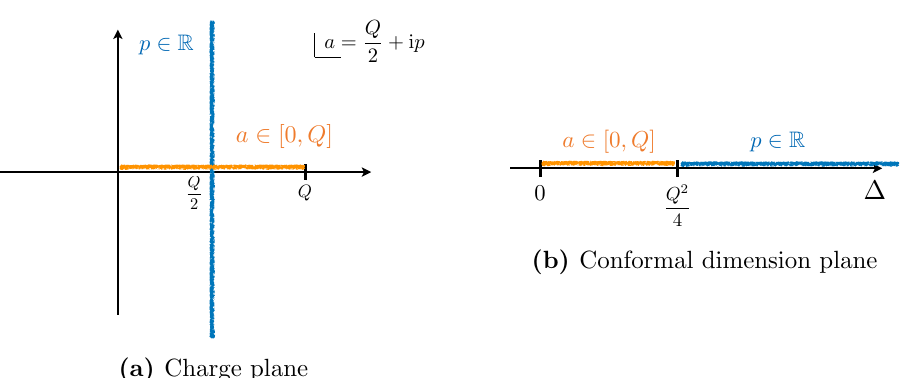
Figure 1. Two branches for the spacelike Liouville charge a , and the corresponding